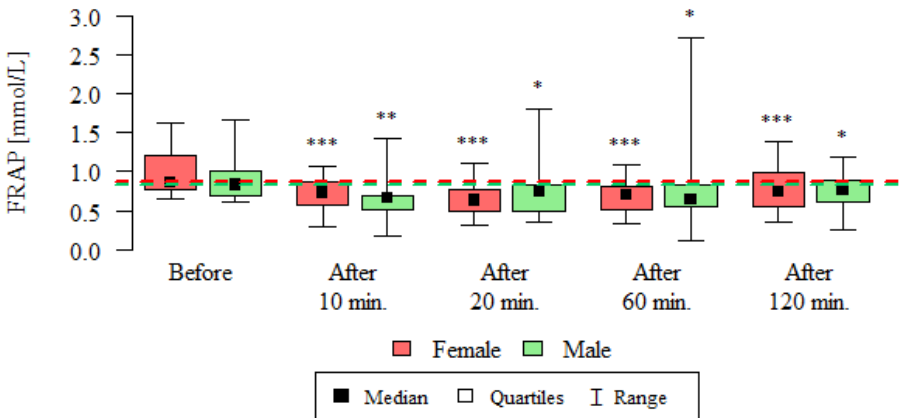
Figure 4. Total antioxidant capacity expressed as FRAP [mmol/L] in the blood of subjects undergoing routine HRCT examination before the test, 10 min, 20 min, 60 min and 120 min after the test. The analysis was carried out using the Wilcoxon test for dependent (repeated) measurements; the graph shows the medians, quartiles and ranges of values of individual variables. * p — comparison with the measurement before the examination (* p < 0.05, ** p < 0.01, *** p < 0.001) — Wilcoxon test for dependent (repeated) measurements.